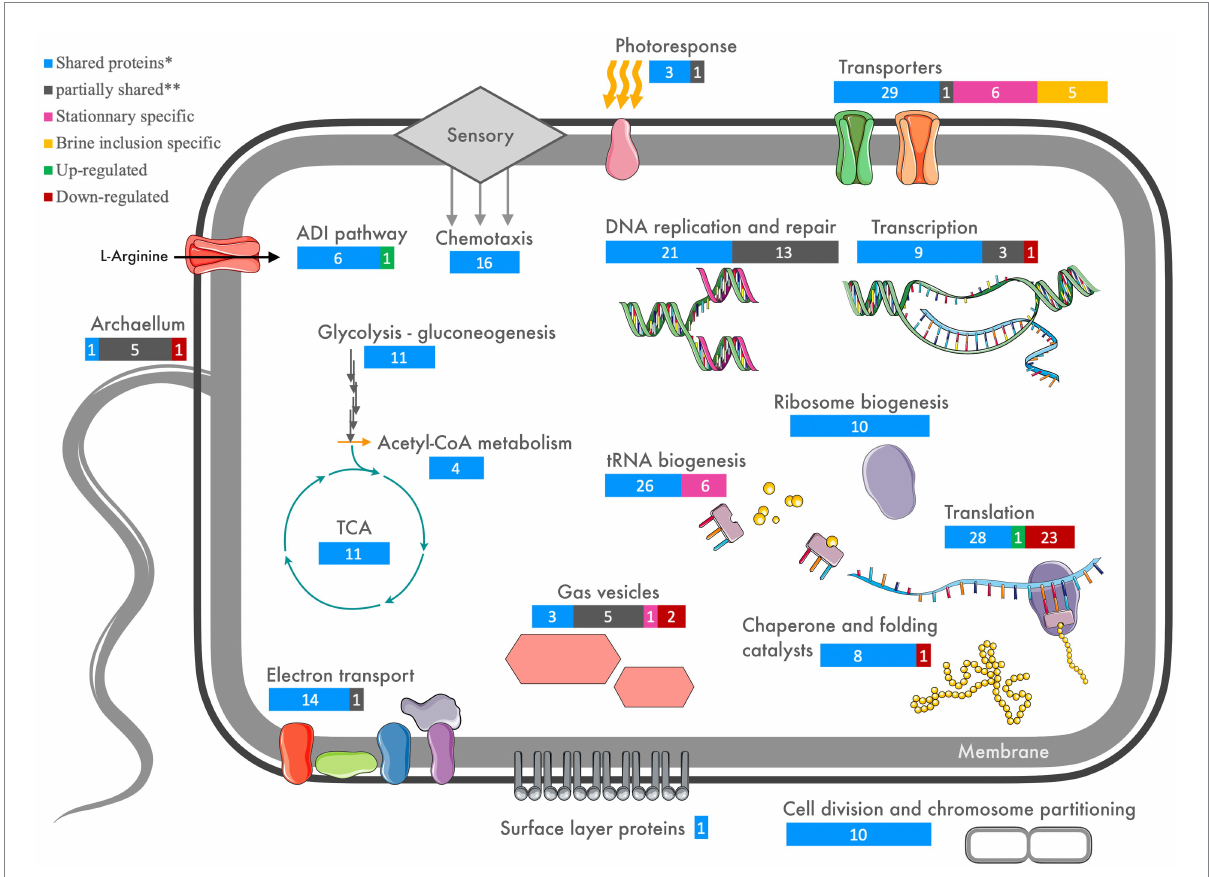
FIGURE 6 Schematic overview of targets cellular functions involved in early acclimation of Halobacterium salinarum through halite brine inclusions (for extended matched proteins, see Supplementary Table 6-5). Shared (*) indicates proteins found in all four brine inclusion extracts and all four liquid stationary culture extracts. Partially shared (**) indicates proteins found in both brine inclusions and stationary phase liquid cultures, but not for all replicate samples for each